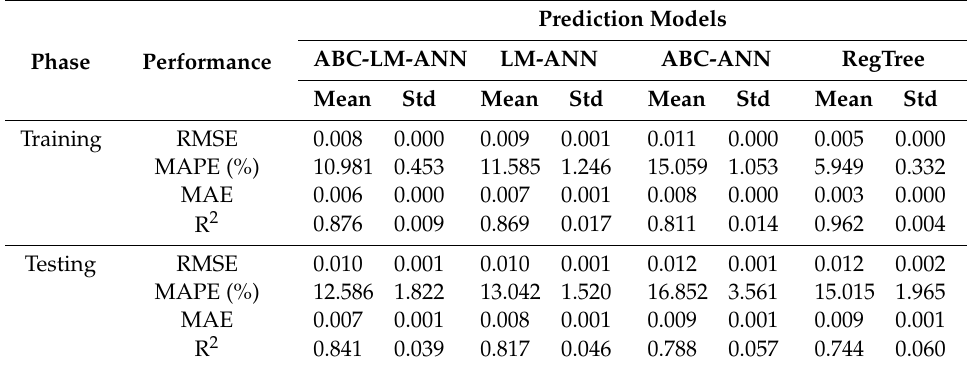
Table 4. The result obtained from the repetitive random subsampling with 20